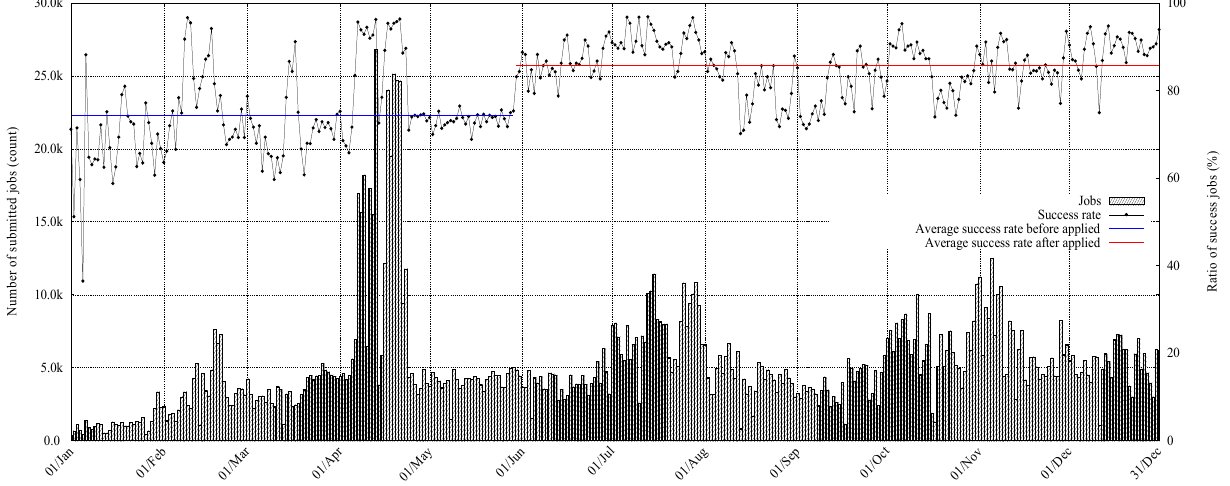
Figure 5. Comparison of job success rate before and after applying K-hook with scheduling.